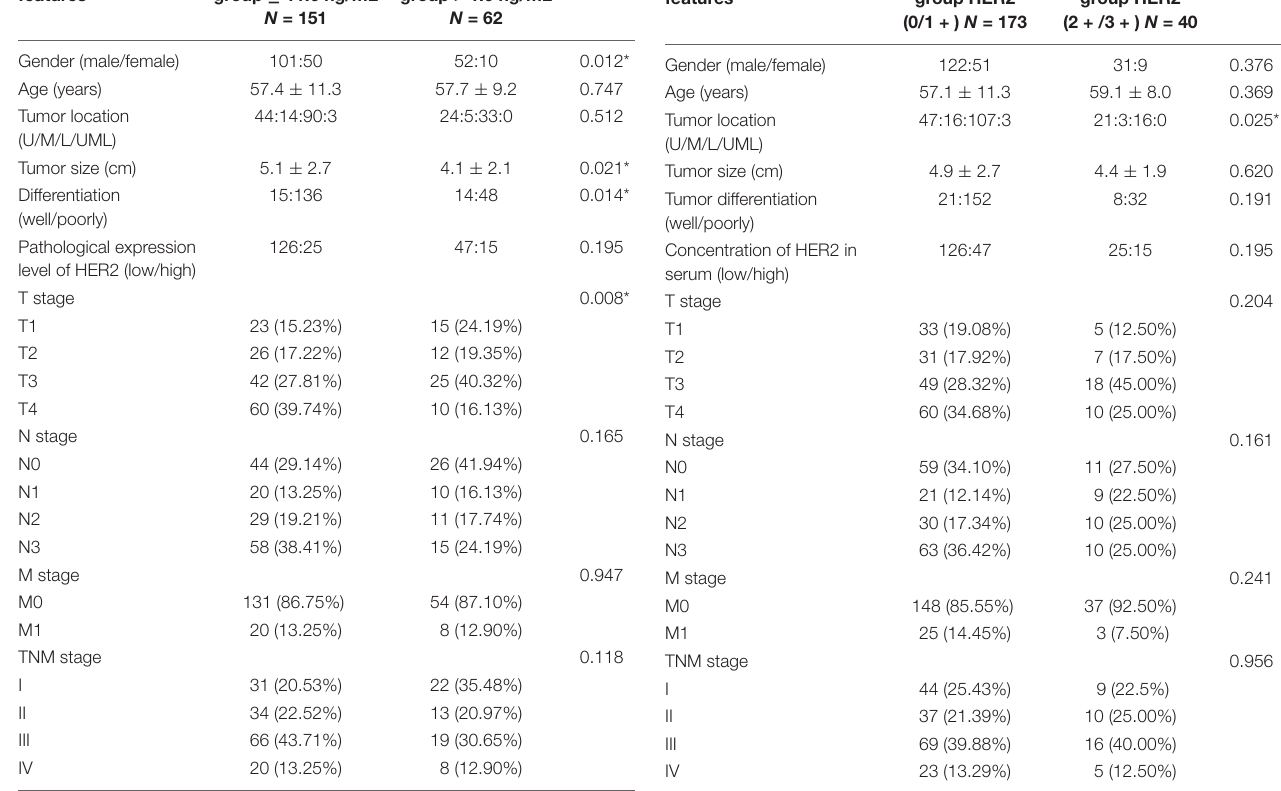
TABLE 2 | Clinicopathological characteristics of all patients separated by pathological level of HER2. Clinicopathological